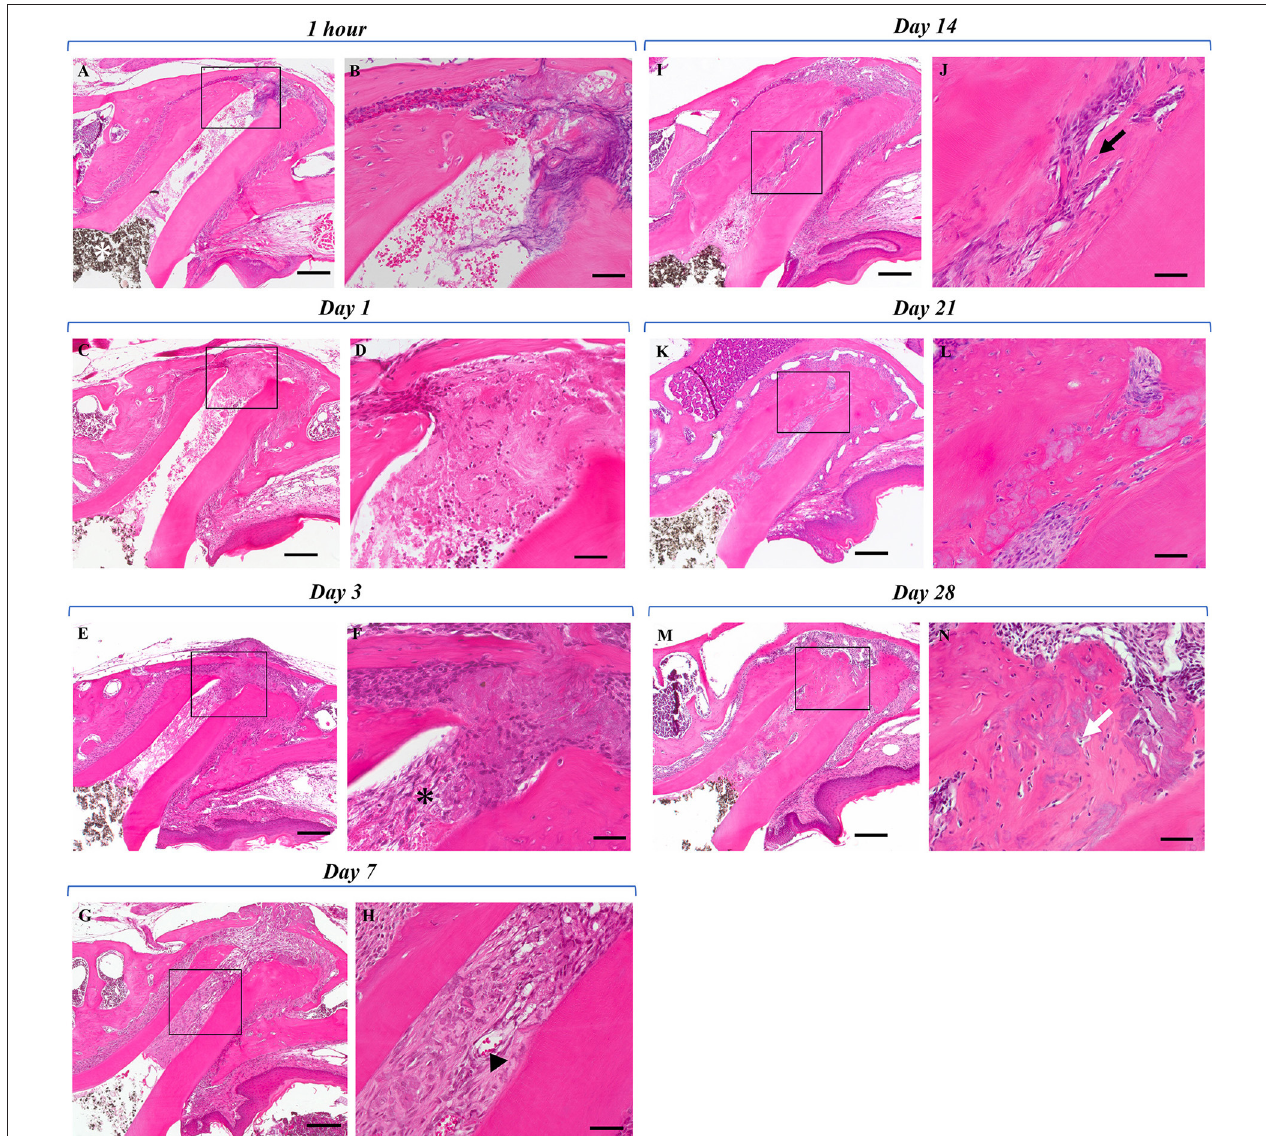
FIGURE 1 | Histological evaluation of the postoperative healing process. (A) One hour post the regenerative endodontics procedure. The pulp tissue of the mesial root was removed and no odontoblasts were found. The root canal was filled with blood clot-like structures containing erythrocyte components. Periodontal ligament tissue around the apex showed debris of torn tissue and partial hemorrhage. Dark brown granules are MTA cement (white asterisk). (B) Higher magnification of the black box area in (A) . (C) One day post the regenerative endodontics procedure. Compared with 1h after the procedure, a decrease of blood clot-like structures was observed in the mesial root canal and around the apex. Although a decrease in erythrocytes was found around the apex, reticulated fibrin was partially observed. (D) Higher magnification of the black box area in (C) . Ingrowth of fibrous tissue from the apex is seen. (E) Three days after the regenerative endodontics procedure. Further reduction of blood clot-like structures was seen in the root canal and around the apex, and the root canal was filled with loose fibrous tissues. (F) Higher magnification of the black box area in (E) . Spindle-shaped fibroblast-like cells (black asterisk) were observed from the apex instead of blot clots. (G) Seven days post the regenerative endodontics procedure. No blood clot-like structures were observed in the root canal, and dense fibrous tissues with vessels were seen in the root canal. (H) Higher magnification of the black box area in (G) . Dilated vessels were observed in the root canal (arrowhead). (I) Fourteen days post the regenerative endodontics procedure. Newly formed mineralized tissue was observed in the root canal. Mineralized tissue was added adjacent to the apex and the root canal wall, and was also found directly beneath the MTA cement. The area of fibrous connective tissue in the root canal was narrowing. (J) Higher magnification of the black box area in (I) . The newly formed mineralized tissue in the root canal contained cellular components (black arrow). (K) Twenty-one days post the regenerative endodontics procedure. Compared with 14 days after the procedure, the mineralized tissue added to the root canal wall and the root width around the apex increased over time. (L) Higher magnification of the black box area in (K) . Extensive mineralized tissue was seen in the root canal and cellular components were present in the matrix. (M) Twenty-eight days post the regenerative endodontics procedure. Bone-like or cementum-like mineralized tissue was widespread in the root canal wall and apex over time. (N) Higher magnification of the black box area in (N) . The apical foramen was closed by the addition of mineralized tissue. Cells were embedded in the matrix of the mineralized tissue (white arrow) (Scale bars = 200 µ m in A, C, E, G, I, K, M; scale bars = 50 µ m in B, D, F, H, J, L, N).